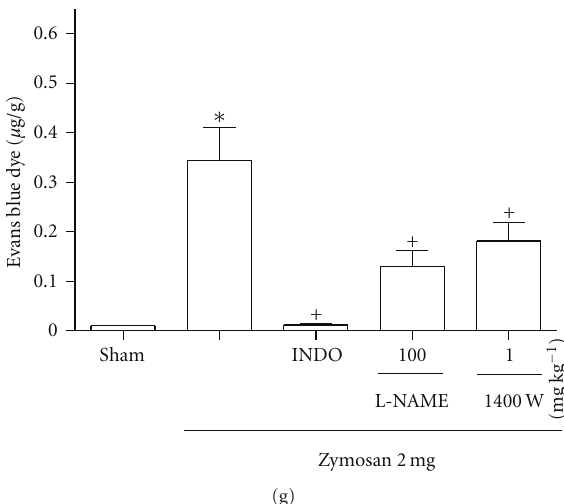
Figure 4: E ff ect of L-NAME and 1400W on the inflammatory and hypernociceptive e ff ects of zymosan in TMJ. Zymosan (2mg; 40 μ L) or saline was injected i.art. into the left TMJ of the rat. L-NAME (100 mg/kg) or 1400W (1mg/kg) was injected (i.p.) 30min before zymosan. The mechanical nociceptive threshold was measured in L-NAME- (a) and 1400W-treated (b) animals before and 4h after an i.art. injection of zymosan or saline. After 6 h, leukocyte migration was evaluated in L-NAME- (c) and 1400W-treated (d) animals by cell counting in TMJ fluid. MPO activity from TMJ fluid in L-NAME- and 1400W-treated animals (e). MPO activity in TMJ tissues in L-NAME- and 1400W- treated animals (f). Plasma extravasation following an i.art. injection of zymosan or saline in L-NAME- and 1400W-treated animals (g). Data are expressed as means ± SEM ( n = 6). ∗ P < . 05 versus Sham. + P < . 05 versus zymosan (ANOVA, Bonferroni).